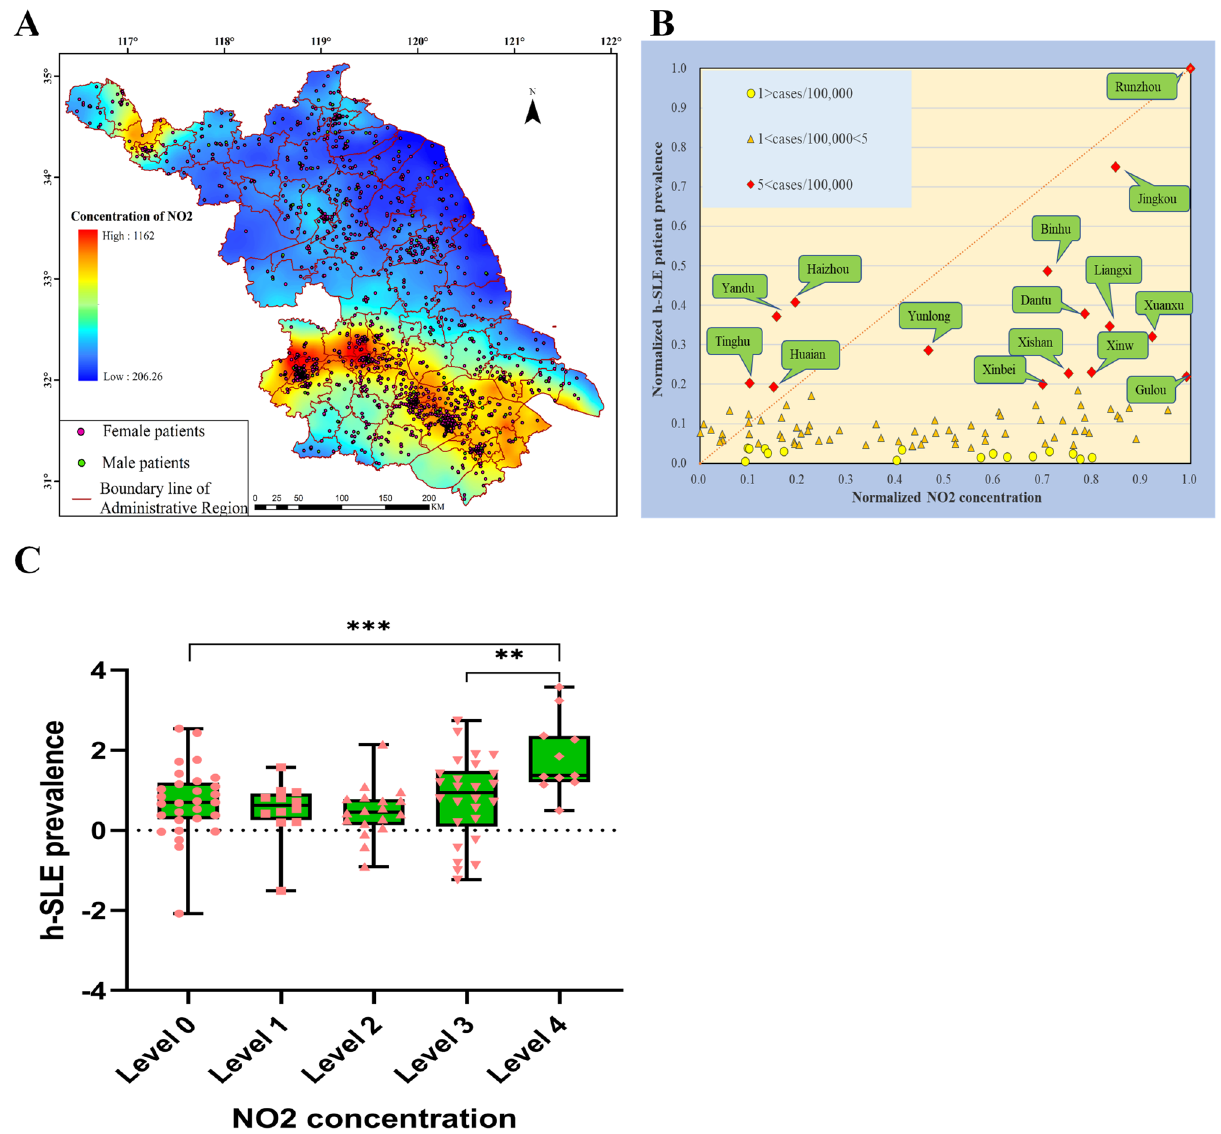
Figure 2. Association between the concentrated discharge of exhaust gas and the development of h-SLE. ( A ) NO 2 concentration distribution in the air of Jiangsu Province in August 2005 (prepared by WQ in ArcMap 10.2, https:// www. esri. com/ zh- cn/ arcgis/ produ cts/ arcgis- pro/ resou rces). ( B ) Normalized graph of h-SLE patient prevalence and air NO 2 concentration in August 2005 in Jiangsu Province from 1999 to 2009. ( C ) Significant difference analysis of the prevalence of h-SLE patients in NO 2 concentration group. Level 0:250–420; Level 1: 420–585; Level 2: 585–750; Level 3: 750–910; Level 4:910–1075. The prevalence of h-SLE patients conformed to the normal distribution after BOX-COX conversion (λ = 0.053) and Shapiro–Wilk Test (P value: 0.186 > 0.05). Statistical analysis was performed with one-way ANOVA. **P < 0.01, ***P <